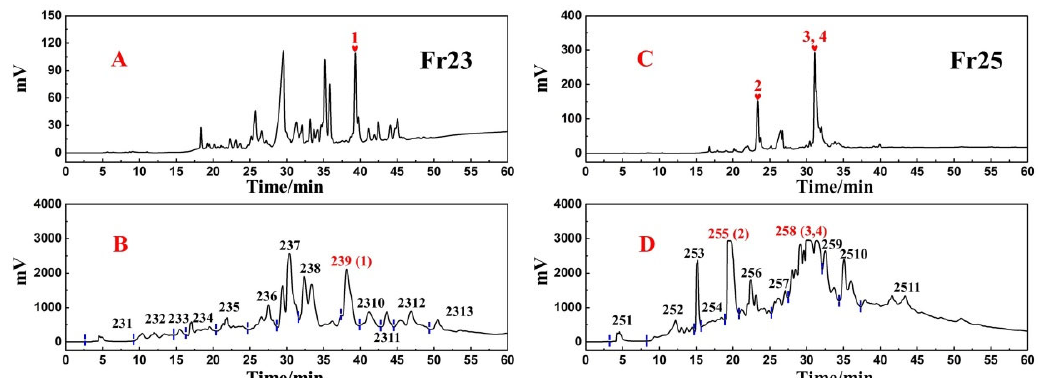
Figure 3. Chromatograms of fractions Fr23 and Fr25, acquired at 210 nm, after analytical ( A , C , respectively) and preparative ( B , D , respectively) chromatography on the Click XIon columns. Analysis was carried out at a flow rate of 1.0 mL/min, using a column temperature of 30 °C, with 0.1% v / v trifluoroacetic acid in water and acetonitrile (ACN) as mobile phases A and B, respectively, and with a gradient of 0–60 min using 100–60% B. For preparation, similar conditions were applied, except that the column was at room temperature and a flow rate of 19.0 mL/min was selected. Peaks 1–4 represent active fraction peaks, respectively.